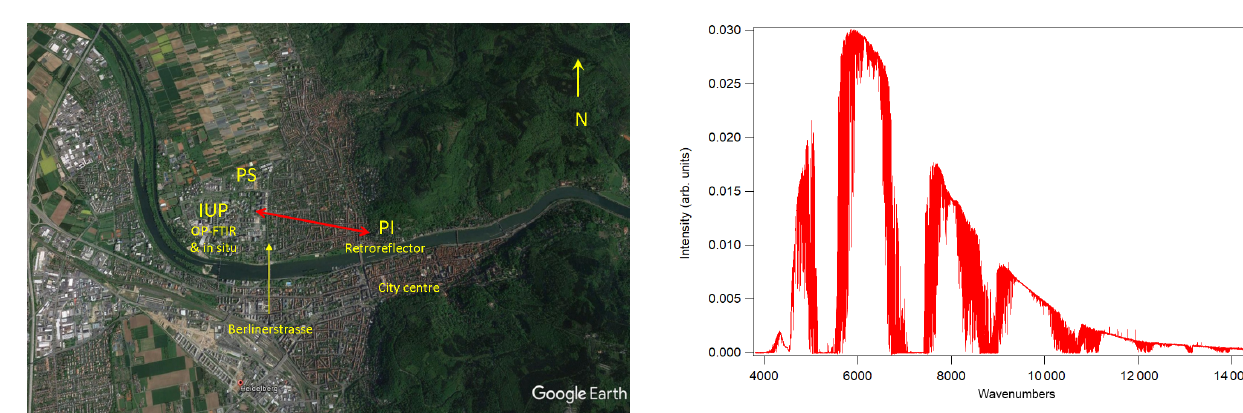
Figure 2. Aerial view of Heidelberg and the 1.5km measurement path. IUP is the Institute of Environmental Physics (FTS and tele- scope, in situ measurements), PI is Physics Institute (retroreflector), PS is power station. The measurement path is mostly over residen- tial areas. There is an extensive small-agricultural area to the north and northwest.